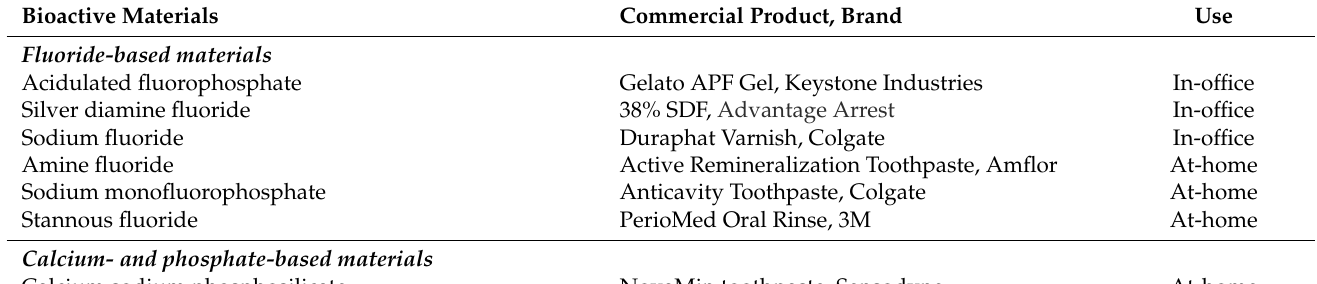
Table 2. Some commercial products of bioactive